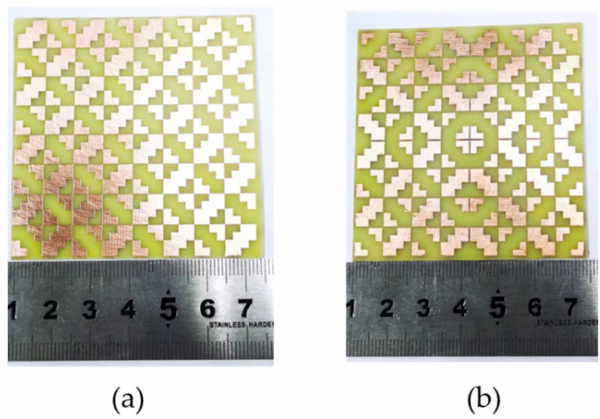
Figure 10. Physical fabrication: ( a ) PCM and ( b ) RCS plane.